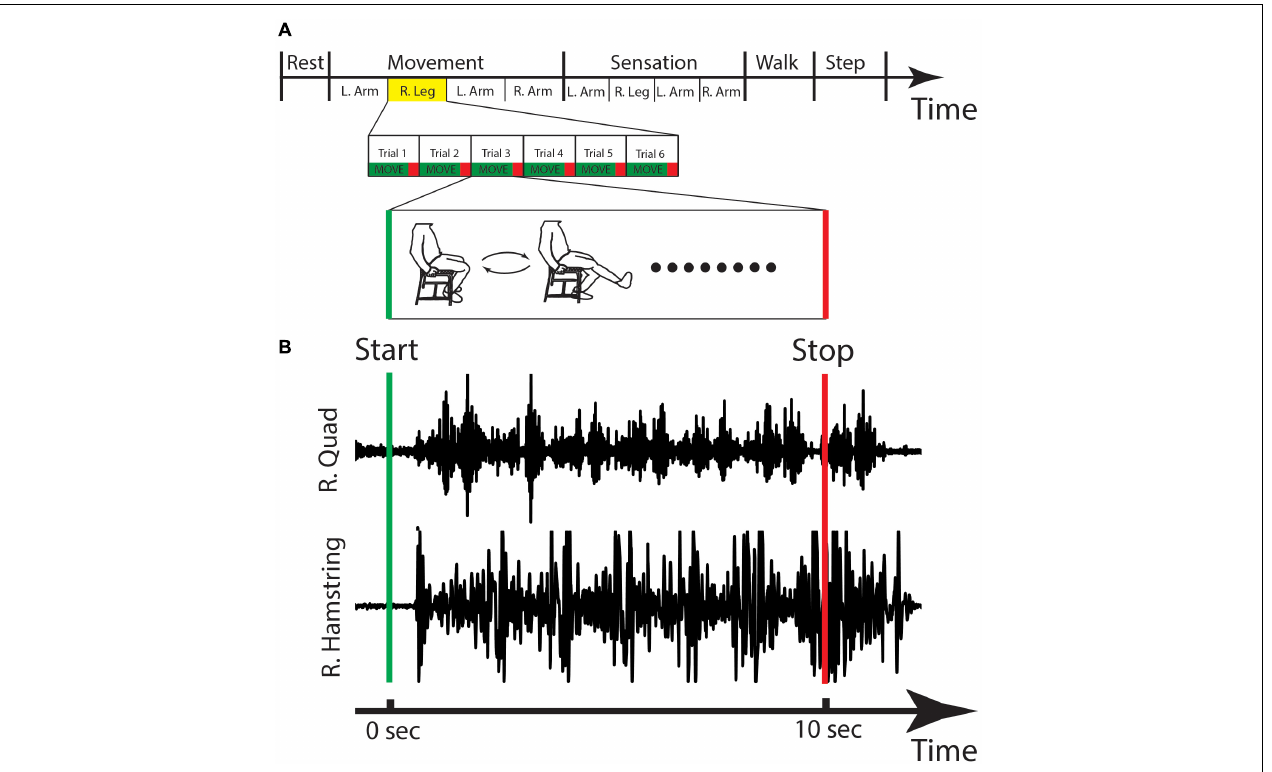
FIGURE 5 | Behavioral task and EMG. (A) The stages of the behavioral task are shown, with the right leg movement highlighted and expanded in the lower panels with a cartoon figure of the type of movement that is done during this stage. (B) The EMG activity for one cycle of right leg movement showing the activations of the right quadricep (R. Quad) and the right hamstring (R. Hamstring). Sec, seconds; L, left; R,